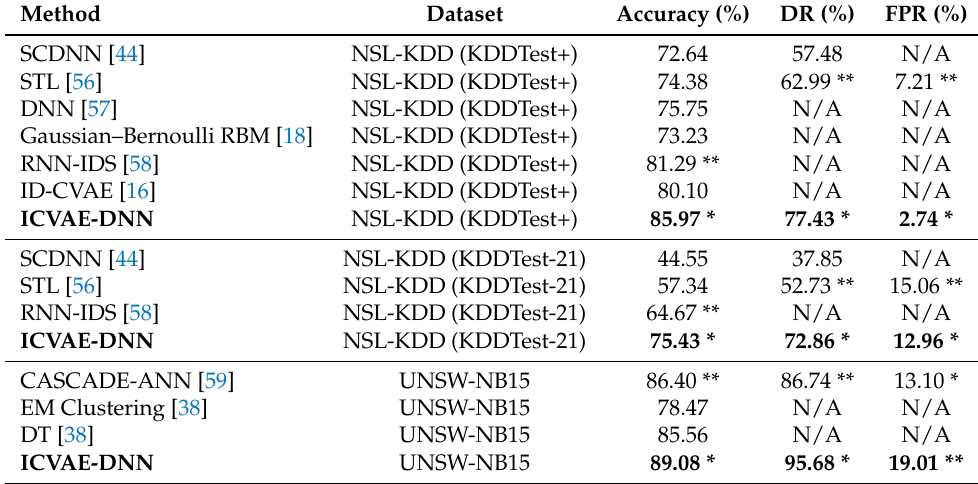
Table 12. Comparison results based on NSL-KDD and UNSW-NB15 datasets (N/A means no available results, * Ranked first, ** Ranked